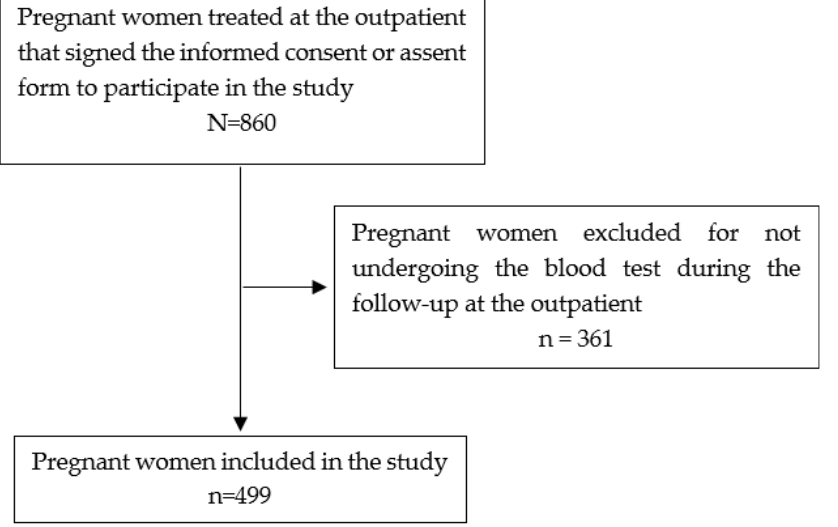
Figure 1. Inclusion flow of pregnant women participating in the study, Manaus, 2020.